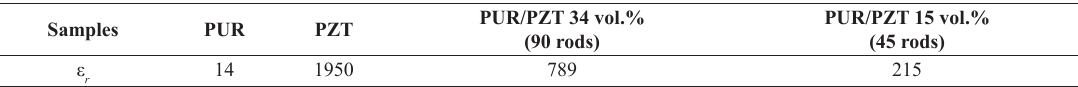
value of the samples of 1-3 PUR/PZT composites, neat PUR and PZT at 1 kHz. Table 1. ε r Samples